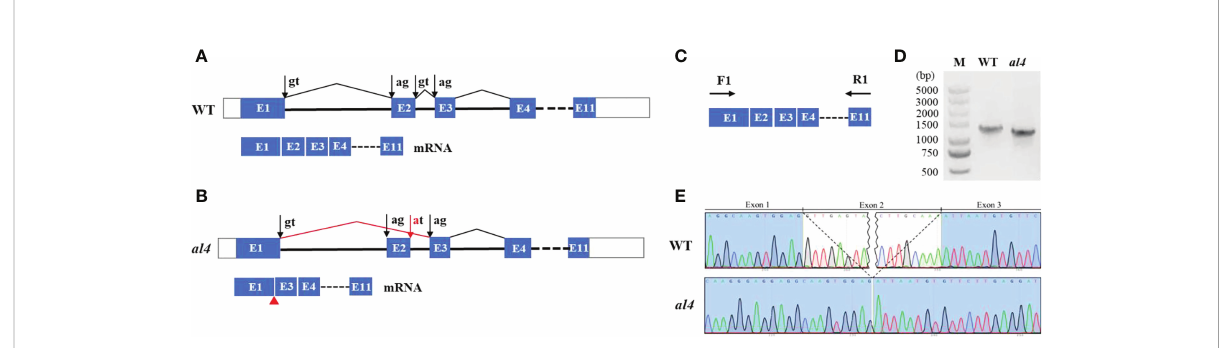
FIGURE 3 Intron mutation of OsIspE results in exon skipping. (A) Schematic representation of the structure of the WT genomic sequence of OsIspE . The positions of ‘‘ canonical ’’ splicing sites are shown with black arrows. (B) Exon-intron junction site mutation (red arrow), leading to exon skipping and production of truncated OsIspE in the al4 mutant. (C, D) RT-PCR bands of OsIspE in the wild type and al4 mutant with the speci fi c primers indicated in panel C. (E) Chromatograms of cDNAs regions in the WT and al4 mutant. The entire exon2 is absent in the al4